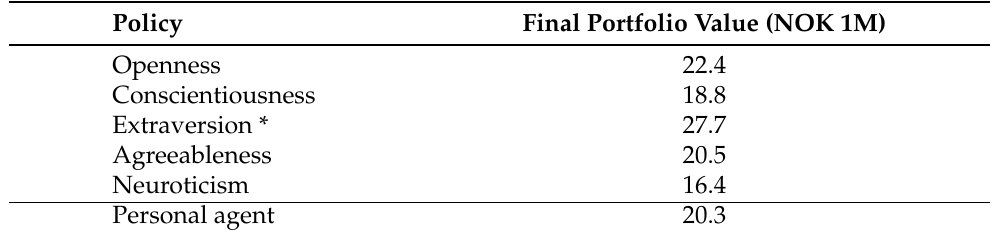
Table 5. Portfolio values of the five optimal policies for each of the prototypical personality traits.